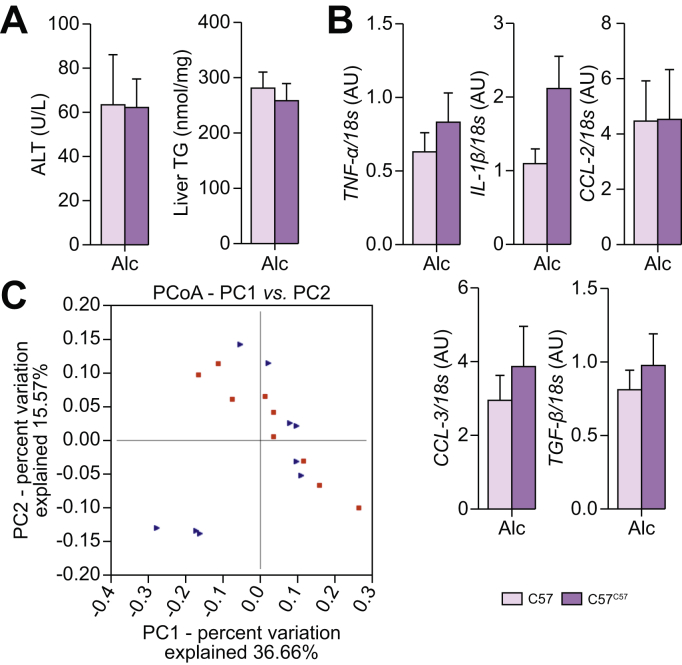
Liver injury in alcohol-fed mice transplanted with their own IM and analysis of the IM. C57BL/6J (C57) mice were fed alcohol. A group was transplanted with their own IM (C57C57). (A) Plasma ALT and liver TG levels. (B) Liver mRNA levels of pro-inflammatory cytokines and chemokines. (C) Bray Curtis PCoA Unifrac distances showing no difference in the composition of the faecal microbiota between groups. Mann-Whitney test. C57 n = 9, C57C57 n = 9. ALT, alanine aminotransferase; IM, intestinal microbiota; PCoA, principal coordinate analysis; TG, triglycerides.